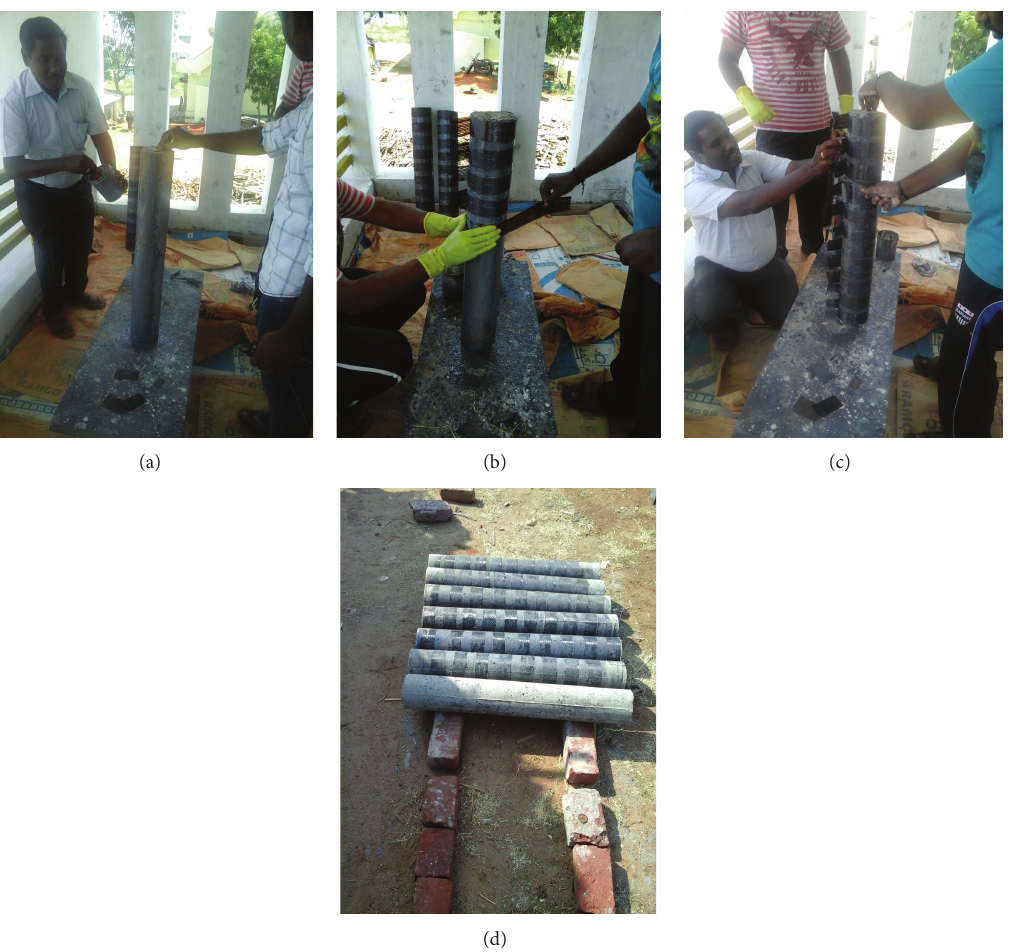
Figure 2: Wrapping procedure [55]: (a) applying resin coating; (b) wrapping CFRP strips; (c) removing excessive resin using steel roller; (d) all strengthened